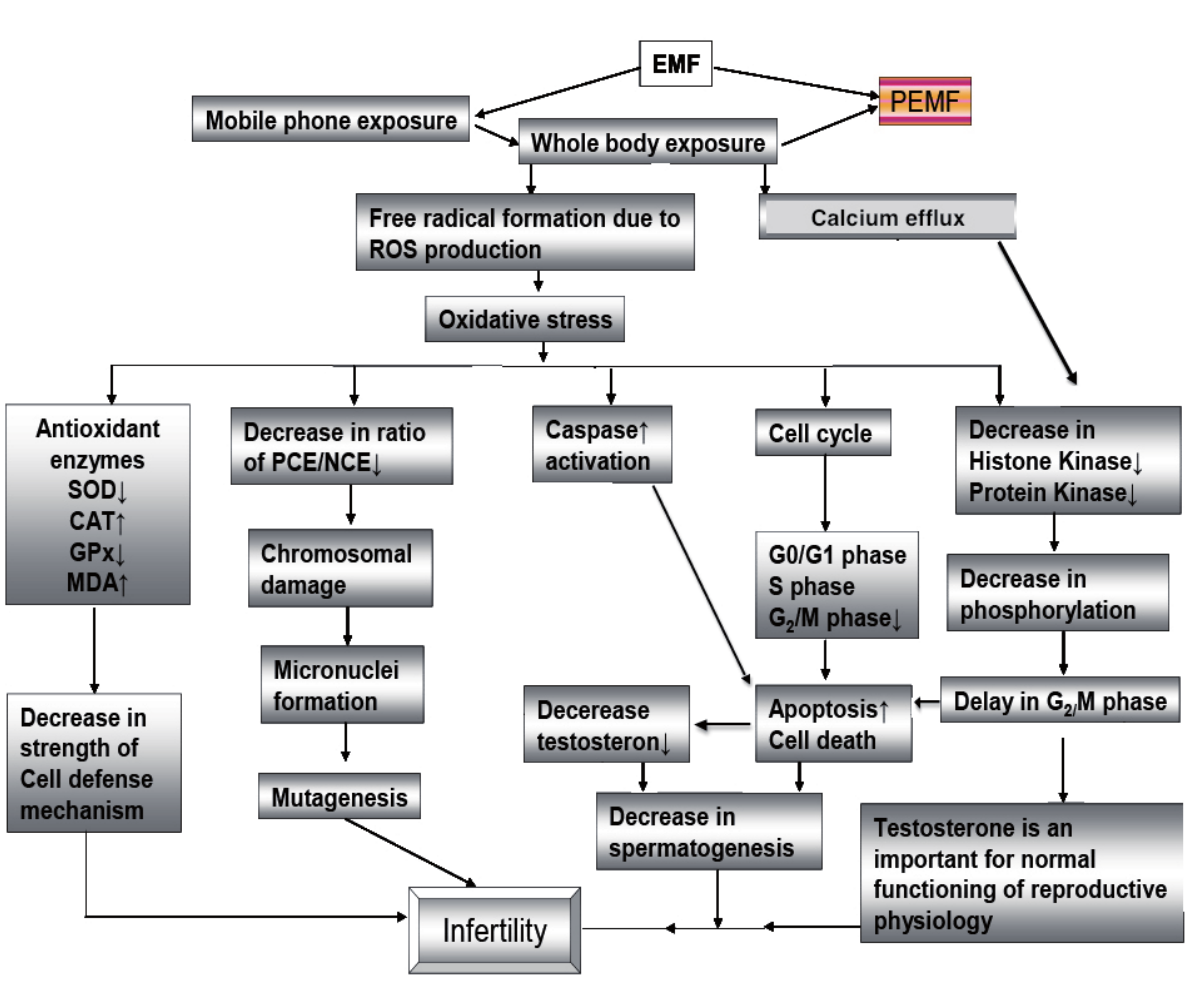
Figure 4 - A summaries of the biological effects of RF-EMR on male reproductive pattern. This figure indicates calcium efflux and enhanced ROS due to mobile phone radiation can cause several changes at enzymatic and hormonal level, which may result infertility. Adapted from Desai 2009